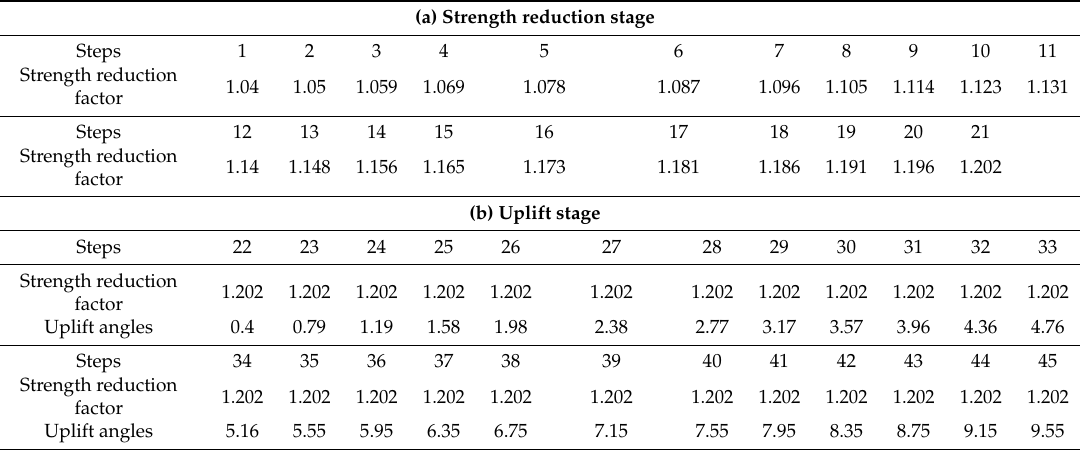
Table 2. Test procedure for the comprehensive